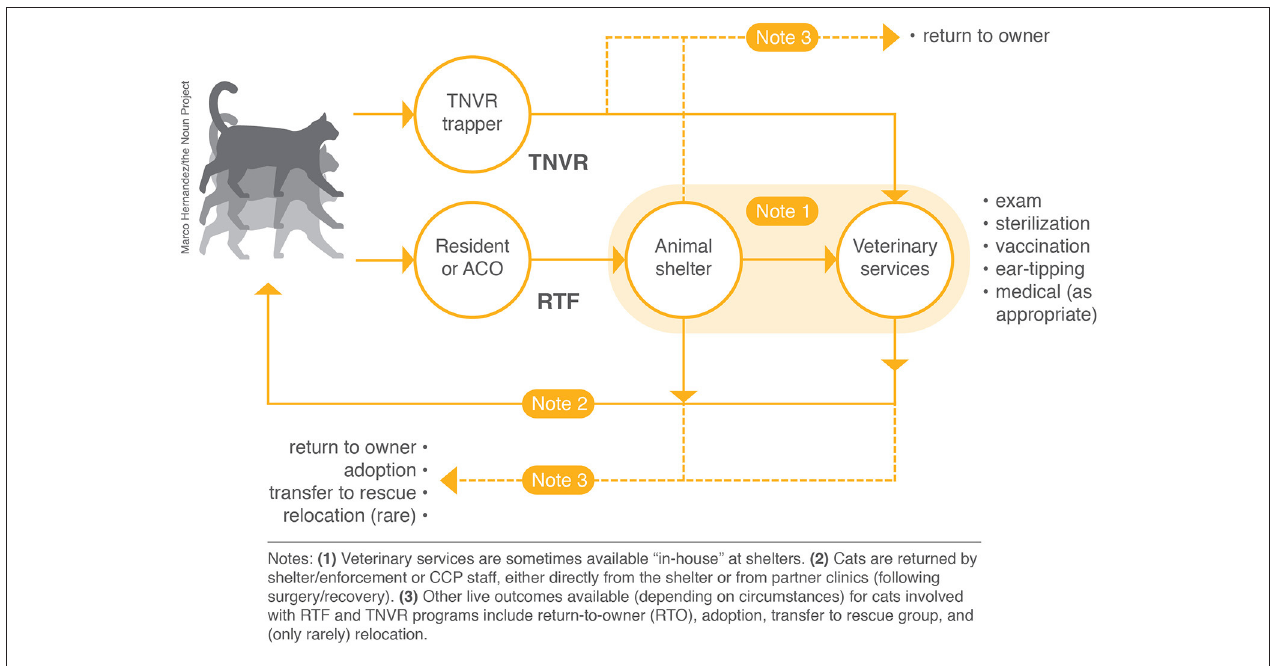
FIGURE 1 | Visual representations of TNVR and RTF